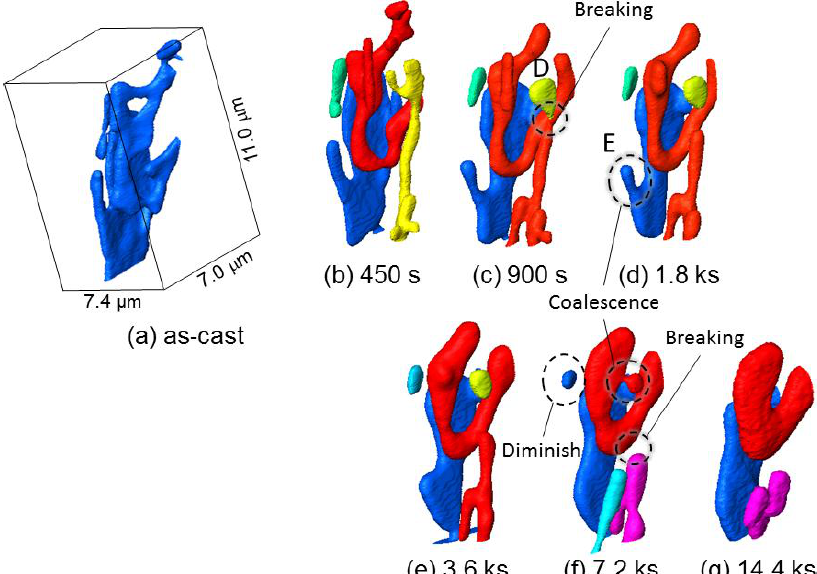
Figure 12. Three-dimensional images viewing Figure 11 from the back side. ( a ) as-cast (one particle), ( b ) heat-treated at 773 K for 450 s, ( c ) heat-treated at 773 K for 900 ks, ( d ) heat-treated at 773 K for 1.8